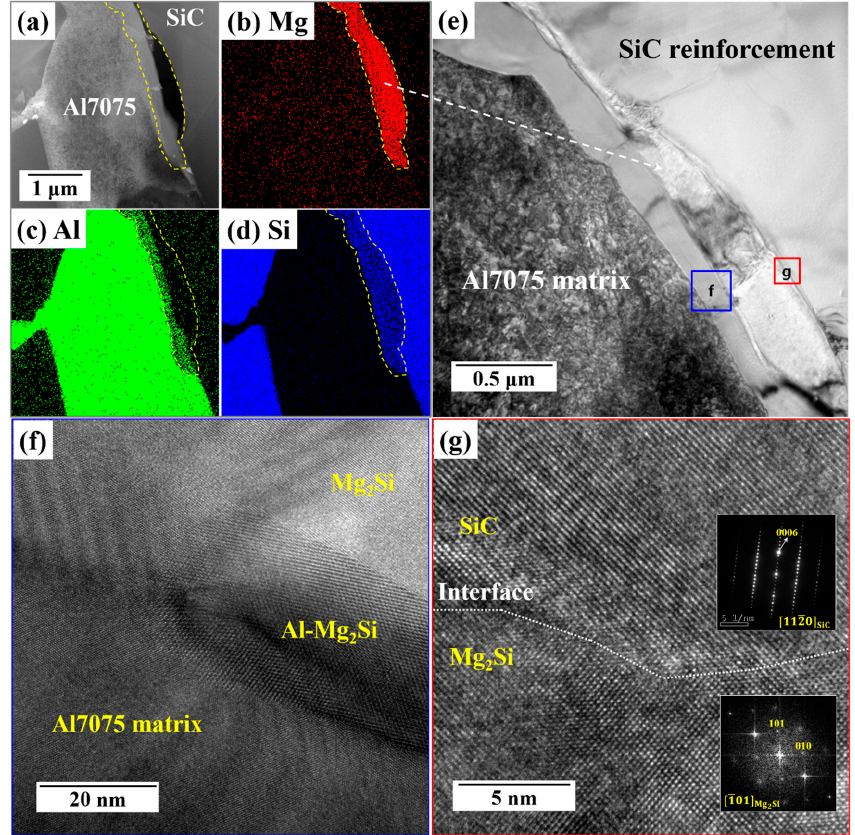
Figure 4. Transmission electron microscope (TEM) images of the BS31 composite after annealing: ( a